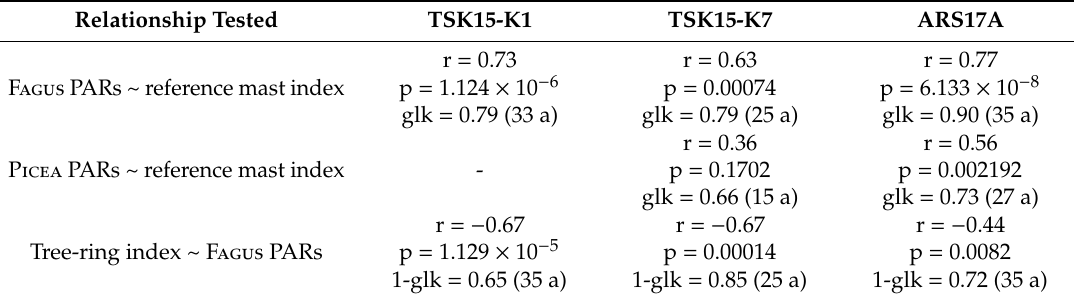
Figure 5. Scatter plots of annual F agus PARs over the reference mast index. Table 3. Correlation coe ffi cients and gleichläufigkeit between annual pollen deposition of F agus and P icea in three lake pollen records and the reference mast index as well as the tree-ring records. Relationship